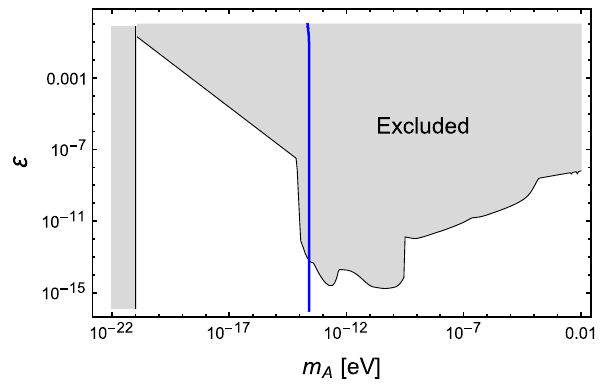
Fig. 1 Existing limits on DP DM presented in [69,70], which include several cosmological and astrophysical constraints [16,59,69–73,131– 133], where the vertical blue line is the plasma frequency today